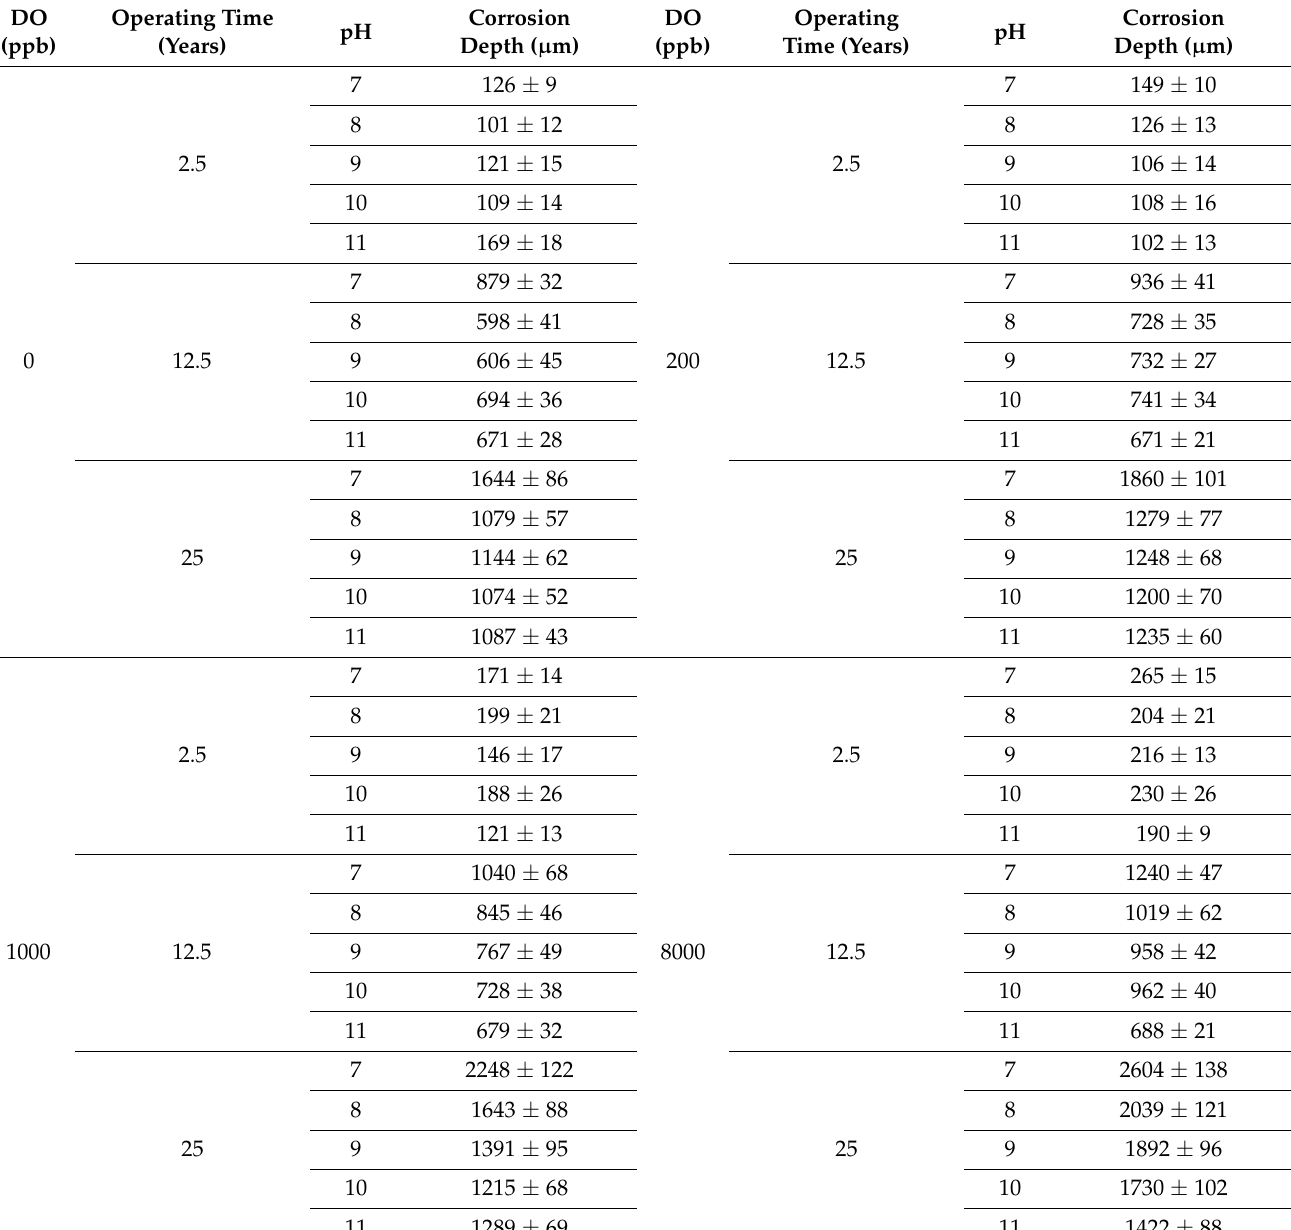
Table 5. The corrosion depth of the HAZ measured using a 3D